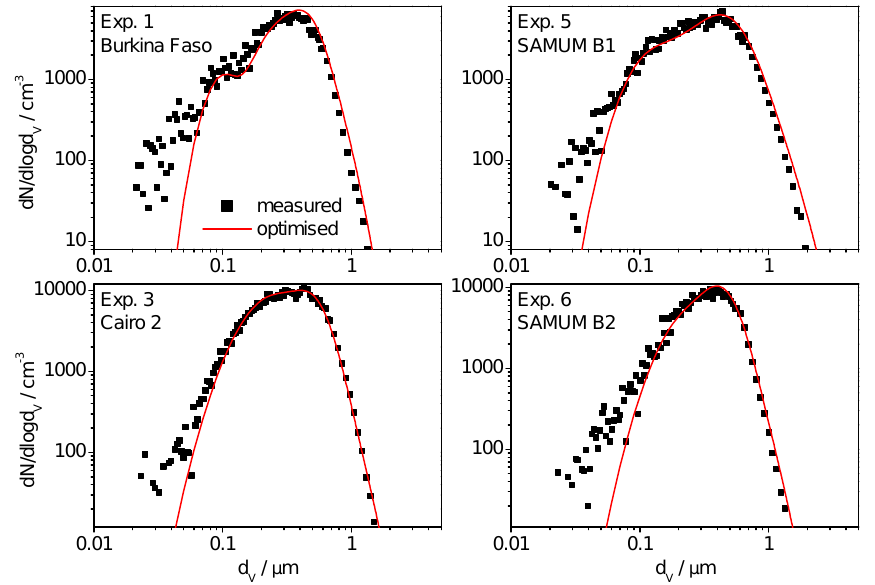
Fig. 9. Comparison between measured (black squares) and optimised (red lines) number size distributions for four further experiments with the dispersed Saharan dust samples, using n = 1 . 53 and ε = 0 . 25